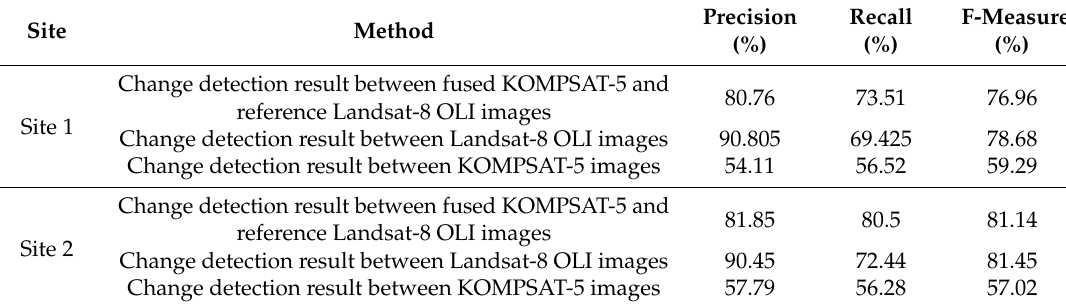
Table 10. Quantitative change detection results based on precision, recall, and the